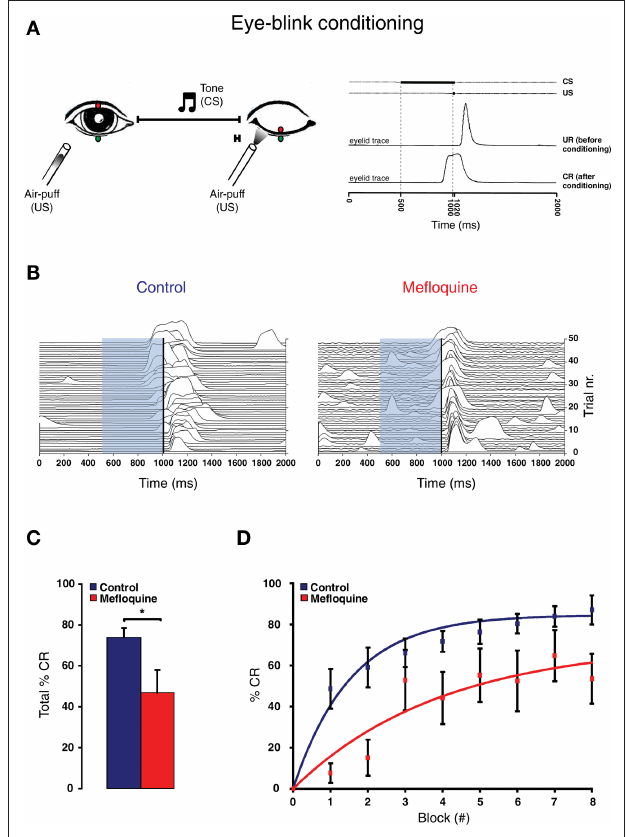
zontal component of the throw. The vertical deviation as well as Figure 4 | eye-blink conditioning is impaired by the intake of mefloquine. (A) Left panel: Schematic drawing of eye-blink conditioning. Right panel: eyelid ( Figure 1C , p = 0. 47 and p = 0.73 respectively, n = 9, t test). In order movement recording of a response before (UR: unconditioned response) and to correct for non-specific inter-trial variability, we normalized the after conditioning (CR: conditioned response). (B) Example of 48 eyelid vertical deviation by the total deviation of each throw. These nor- recordings of a control subject (i.e., no mefloquine use; left panel) and a malized vertical deviations did not reveal a significant difference mefloquine user (right panel) during the acquisition. The conditioned stimulus (CS) is indicated by the light-blue bar, ranging from 500 to 1020 ms. The ( Figure 1D , p = 0.45, n = 9, t test). Neither did the normalized unconditioned stimulus (US) is indicated by the vertical black line, ranging from variation in the vertical deviation, which is an indicator for vertical 1000 to 1020 ms. (C) Histogram of the total number of CRs in % observed in throwing precision ( Figure 1E , p = 0.34, n = 9, t test). control subject (blue, n = 11) and mefloquine users (red, n = 8; * p < 0.05, t test). (D) The average percentages of CRs in each acquisition block is plotted for the control group (blue squares) and mefloquine group (red squares). Learning 2 2 and = = 0 98 0 87. . curves were used to fit both data sets ( R R control mefloquine